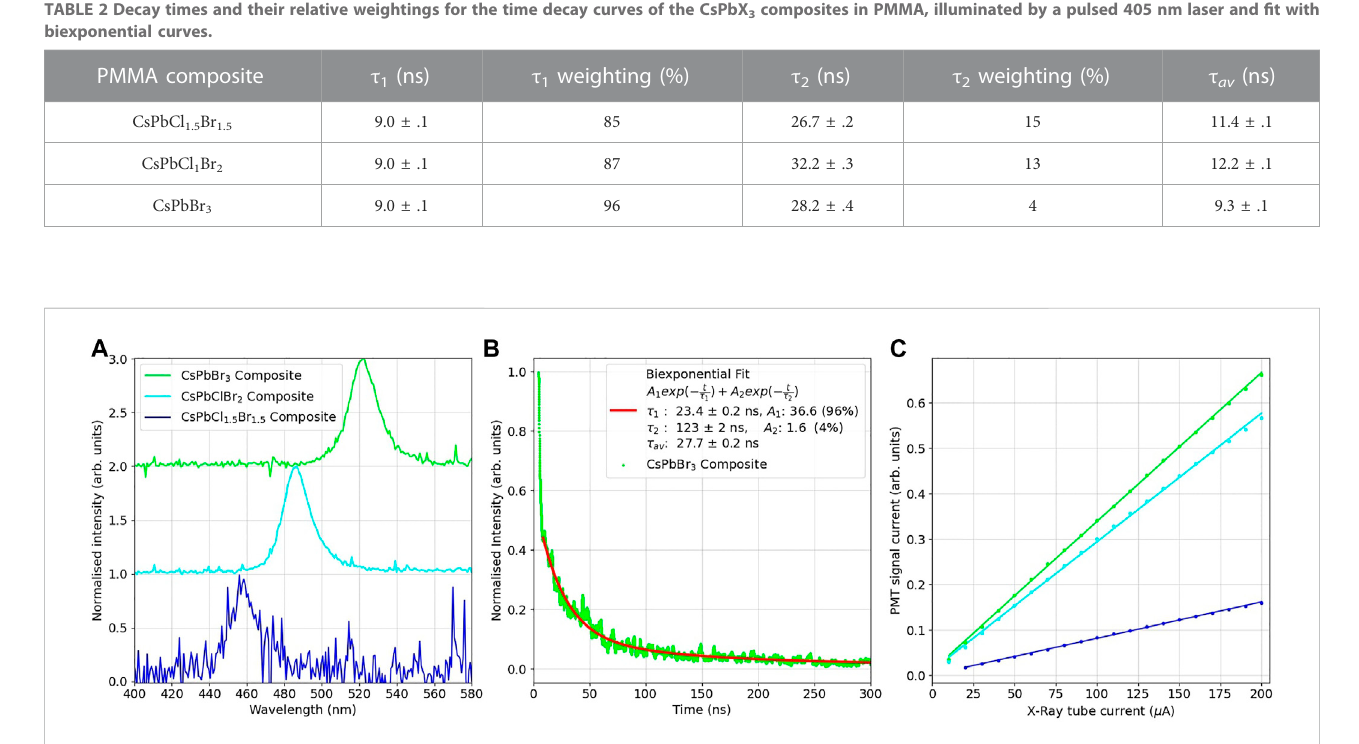
FIGURE 4 (A) NormalisedRLspectraforthePMMA-mixedhalidecompositedisks,illuminatedbyan80 kV,100 μ AX-raysource. (B) Averagedtimedecaypro fi lesof the PMMA-CsPbBr 3 composite disk under illumination by a 75 kV, 2 kA X-ray source, pulsing for 35 ns. (C) RL intensity of the PMMA-mixed halide composite disks, as measured by a PMT at varying dose rates. The PMT signal current as has been adjusted for the quantum ef fi ciency of the